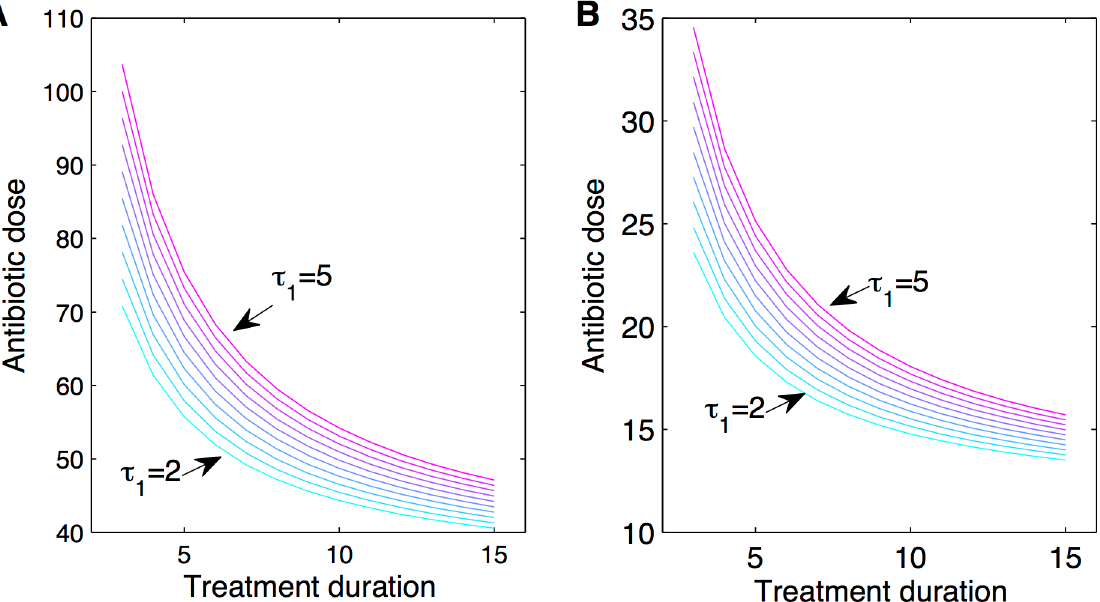
Fig 4. Aggressive treatment guaranteeing infection clearance using a classical regime, without relying on host immunity. Antibiotic dose and treatment duration can be traded-off against one another, at any treatment onset (lines depict τ 1 varying between 2 days and 5 days), to achieve the same final result: infection clearance by the end of therapy. We apply Eq 19 to two infection scenarios: A) a = 0.1, very high resistance; and B) a = 0.3 lower resistance of the drug-resistant bacterial sub-population. Parameters as in Table